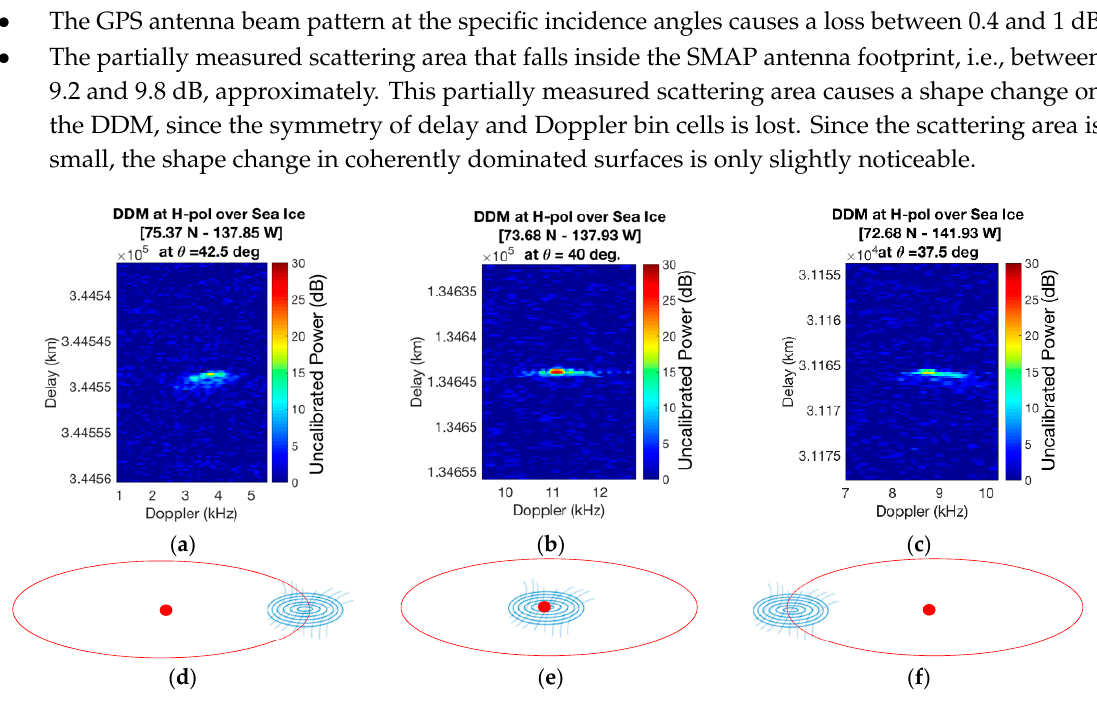
Figure 10. Top: Delay–Doppler Maps of the scattered power measured by SMAP-R for the sea ice surface for ( a ) 42.5 ◦ , ( b ) 40 ◦ , and ( c ) 37.5 ◦ incidence angles. Bottom: iso-delay (blue ellipses) and iso-Doppler lines (blue hyperbolae) computed from SMAP-R and GPS geometries and velocities with the antenna beam pattern limited at –3 dB beamwidth (red) over-imposed to those isolines for the same ( d ) 42.5 ◦ , ( e ) 40 ◦ , and ( f ) 37.5 ◦ incidence angles. Note that they are not to scale: The scattering area represents 1 km major axis ellipse, while the antenna beam patter diameter is 40 km. The antenna boresight is shown as a red